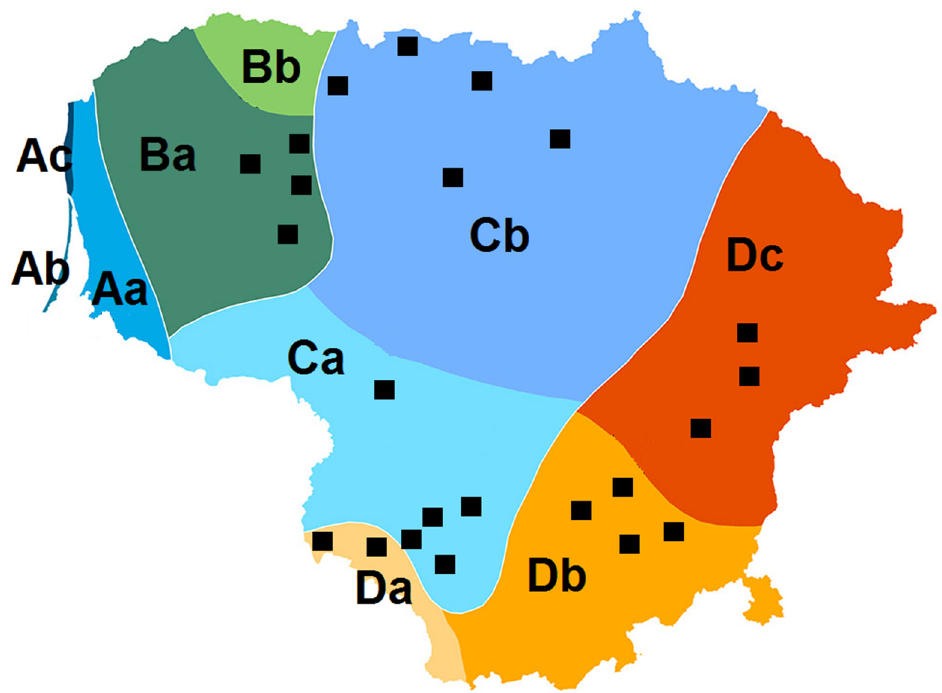
Figure 1. Distribution of hillfort sites (black squares) by climatic regions of Lithuania. Climatic regions: ( A ). Seaside (includes subregions Aa, Ab, and Ac); ( B ). Žemai č iai (includes subregions Ba and Bb); ( C ). Middle Lowland (includes subregions Ca and Cb); ( D ). South-Eastern Uplands (includes subregions Da, Db, and Dc). Each shade of color represents a different climatic subregion (map adapted from https://mapijoziai.lt/lietuvos-klimatas/, accessed on 2 January 2023).